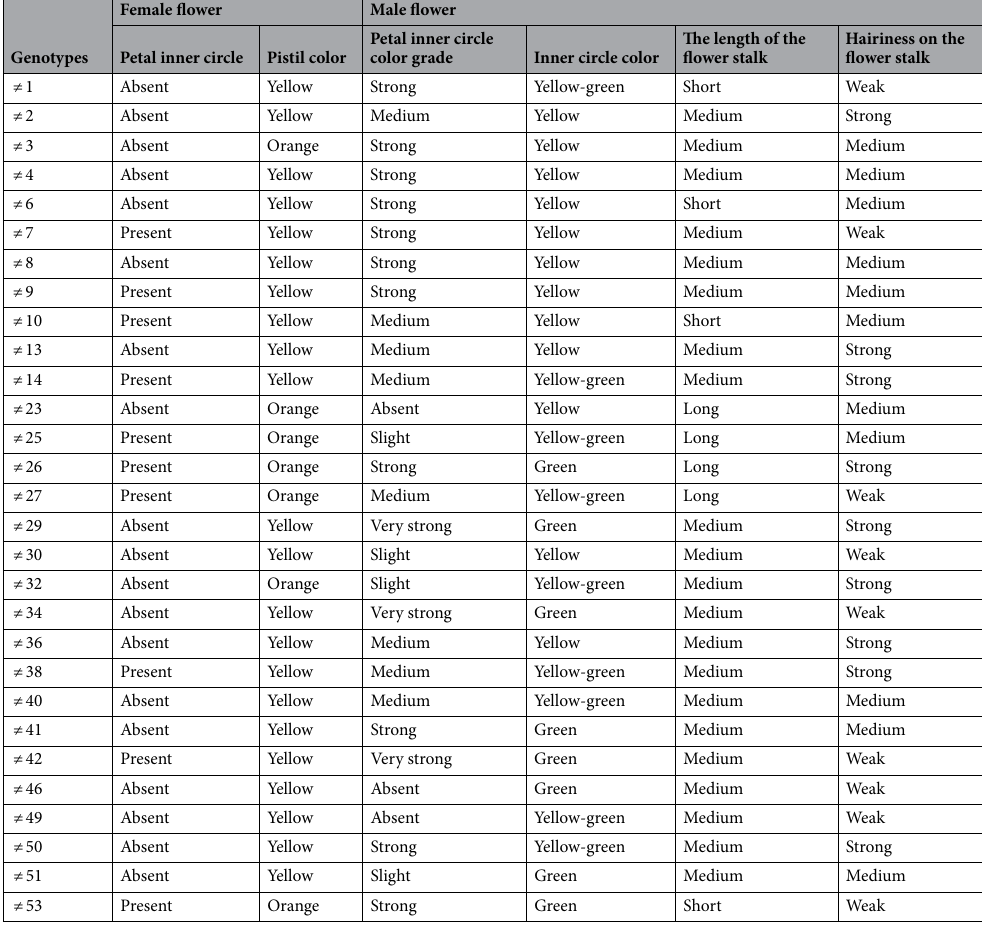
Table 4. Flower morphological parameters of pumpkin